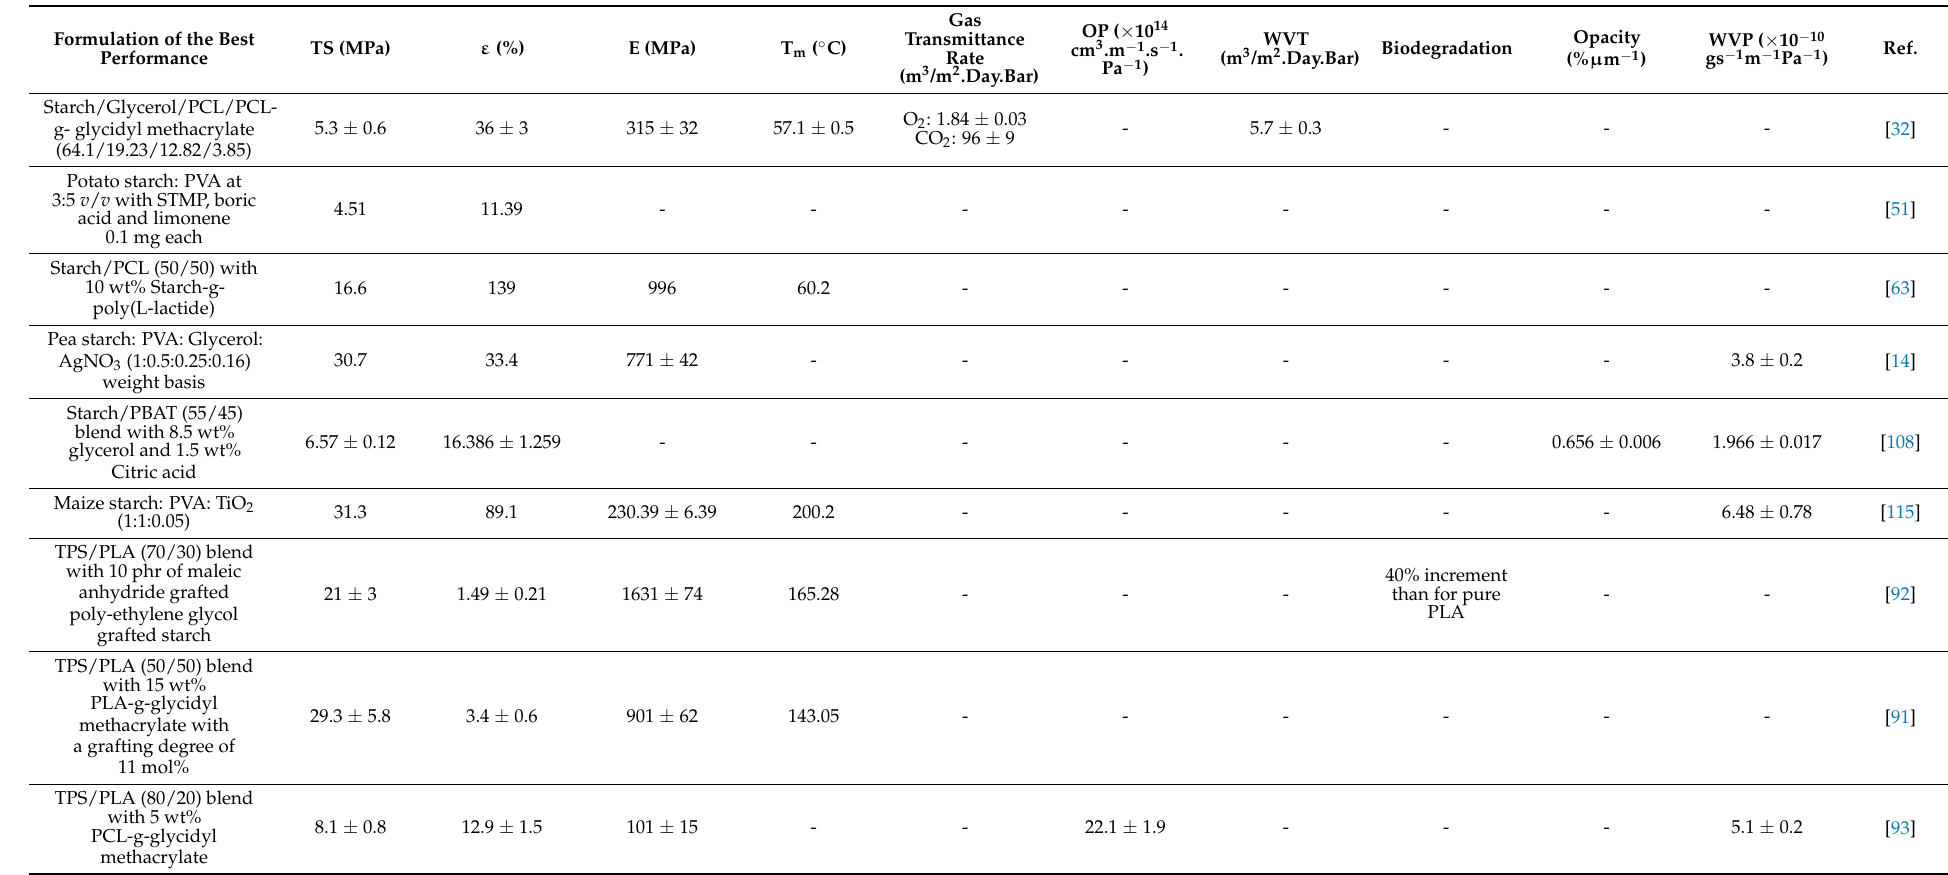
Table 10. Comparison of properties of compatibilized Starch/Synthetic biodegradable polymer blends ctd. Formulation of the Best